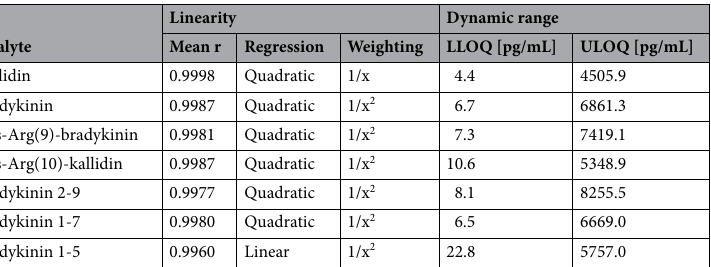
Table 2. Results for the assessment of linearity (n = 6) with corresponding peptide-specific nominal concentrations of the LLOQ and ULOQ. LLOQ: lower limit of quantification, ULOQ: upper limit of